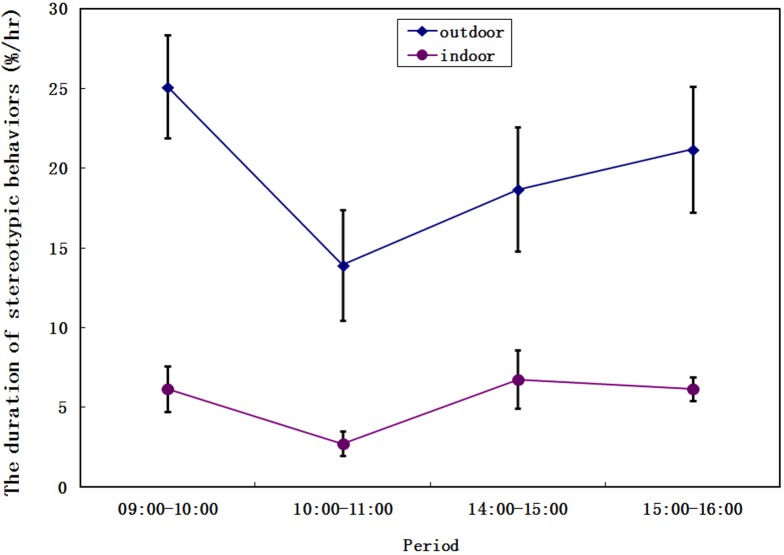
The duration of stereotypies in different periods between outdoor enclosures and indoor enclosures.Standard errors are represented in the figure by the error bars attached to each sign. Diamonds represent outdoor enclosures, circles represent indoor enclosures.